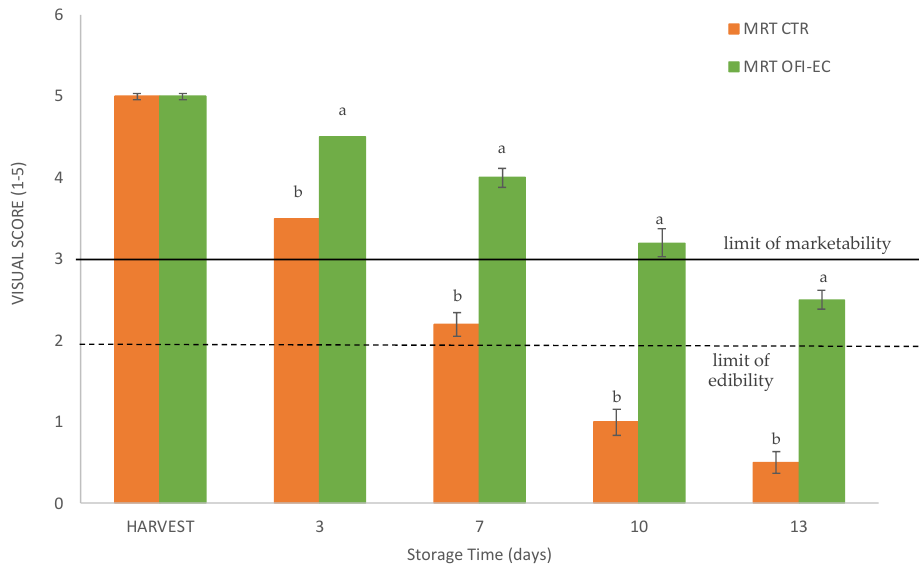
Figure 8. Visual score of minimally processed Martorana loquat fruits, untreated fruit (MRT CTR), and fruits treated with mucilage (MRT OFI-EC) during cold storage (13 days at 5 °C). Different lowercase letters indicate significant differences between the treatments on each sampling date. Data are the mean ± SE (vertical bars represent standard error; n = 5 ). Data are the mean ± SE (vertical bars represent standard error; n = 5 ) with 5 = very good, 4 = good, 3 = fair (limit of marketability), 2 = poor (limit of edibility) and 1 = very poor (inedible).